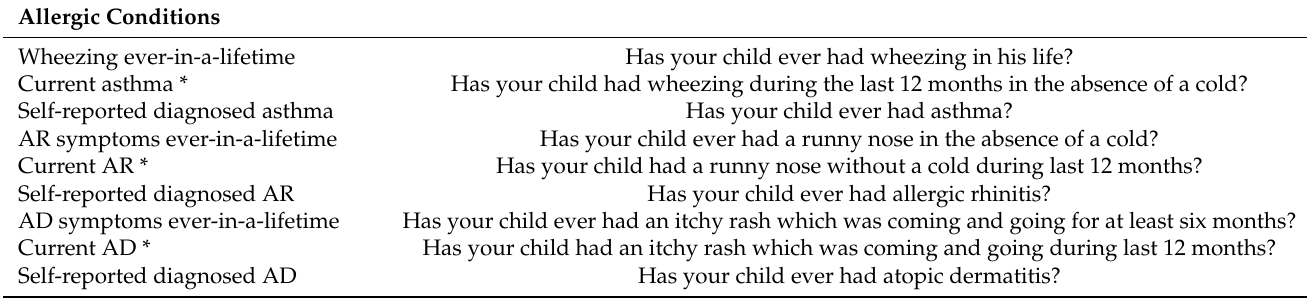
Table 1. Epidemiological definition of asthma, allergic rhinitis (AR) and atopic dermatitis